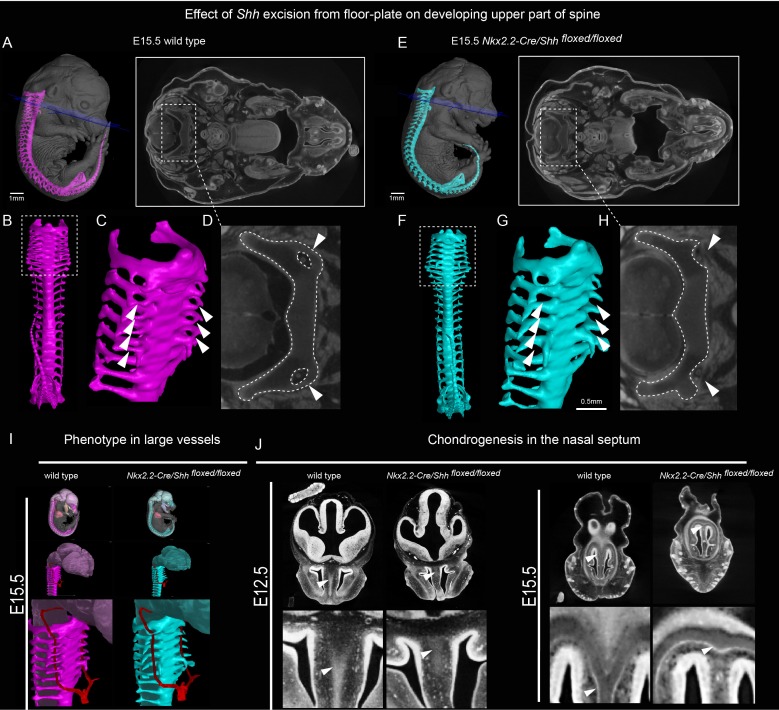
Phenotypic manifestation of Shh genetic ablation from the floor-plate, analyzed at E15.5 upper part of spine.(A–C, E–G) 3D-models of upper parts of spine of (E–H) mutant (Nkx2.2-Cre/Shhfloxed/floxed) and (A–D) control embryo, analyzed at E15.5. (D, H) raw CT slices showing corresponding location marked with white dotted rectangle in (A) and (E). Mutant embryo shows incomplete transverse foramina of cervical vertebrae. (I) Further analysis of showing left and right vertebral arteries traversing the transverse foramina of the cervical vertebrae. (J) Raw CT data – slices showing the different chondrogenesis in both E12.5 and E15.5 embryos between wild type and Nkx2.2-Cre/Shhfloxed/floxed. Major differences are pointed at by arrows.